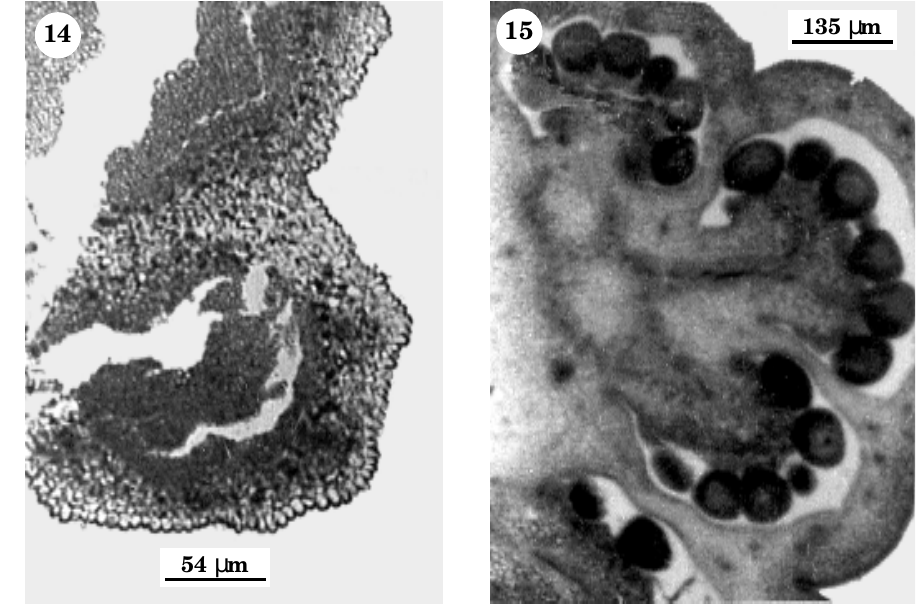
(18).Fig. 14-15. Cross sections of ovary of Marmande tomato flower infected with TMV-M showing the general form of the lower region of the ovary (14), general form of the middle region of the ovary with ovules and carpel traces